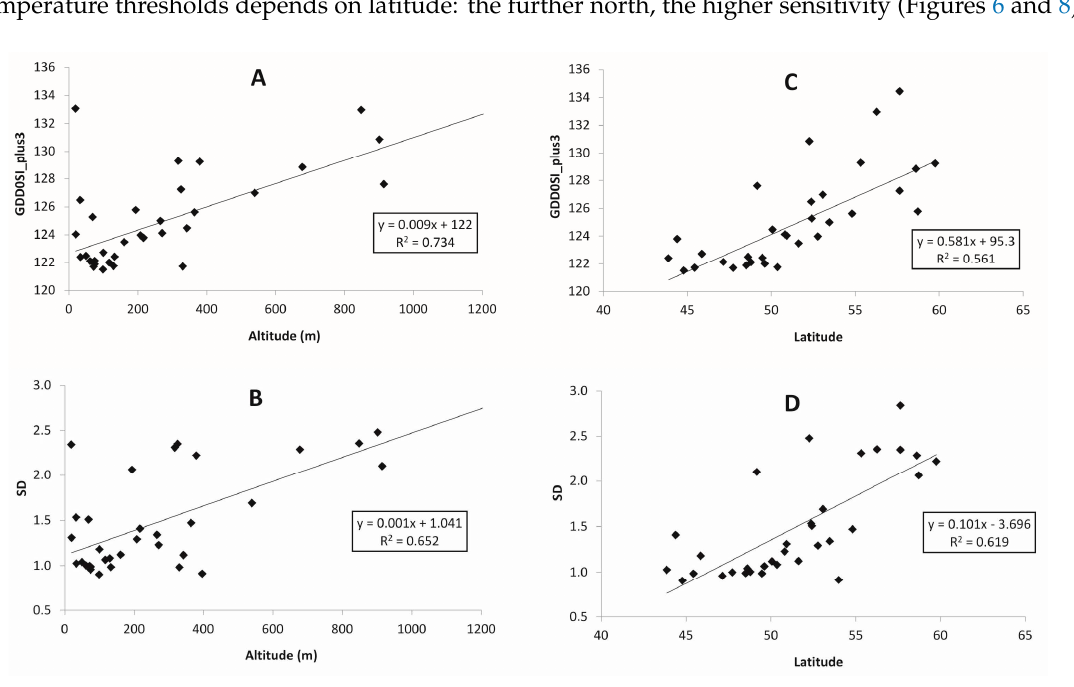
Figure 6. Dependence of Sensitivity Index for growing degree days with 15 °C threshold (GDD15SI) and its standard deviation (SD) for a GDD15 +3 scenario on altitude and latitude for continental locations in the Russian Far East for the period 1966–2017: ( A , B ) altitude (m), ( C , D ) latitude.